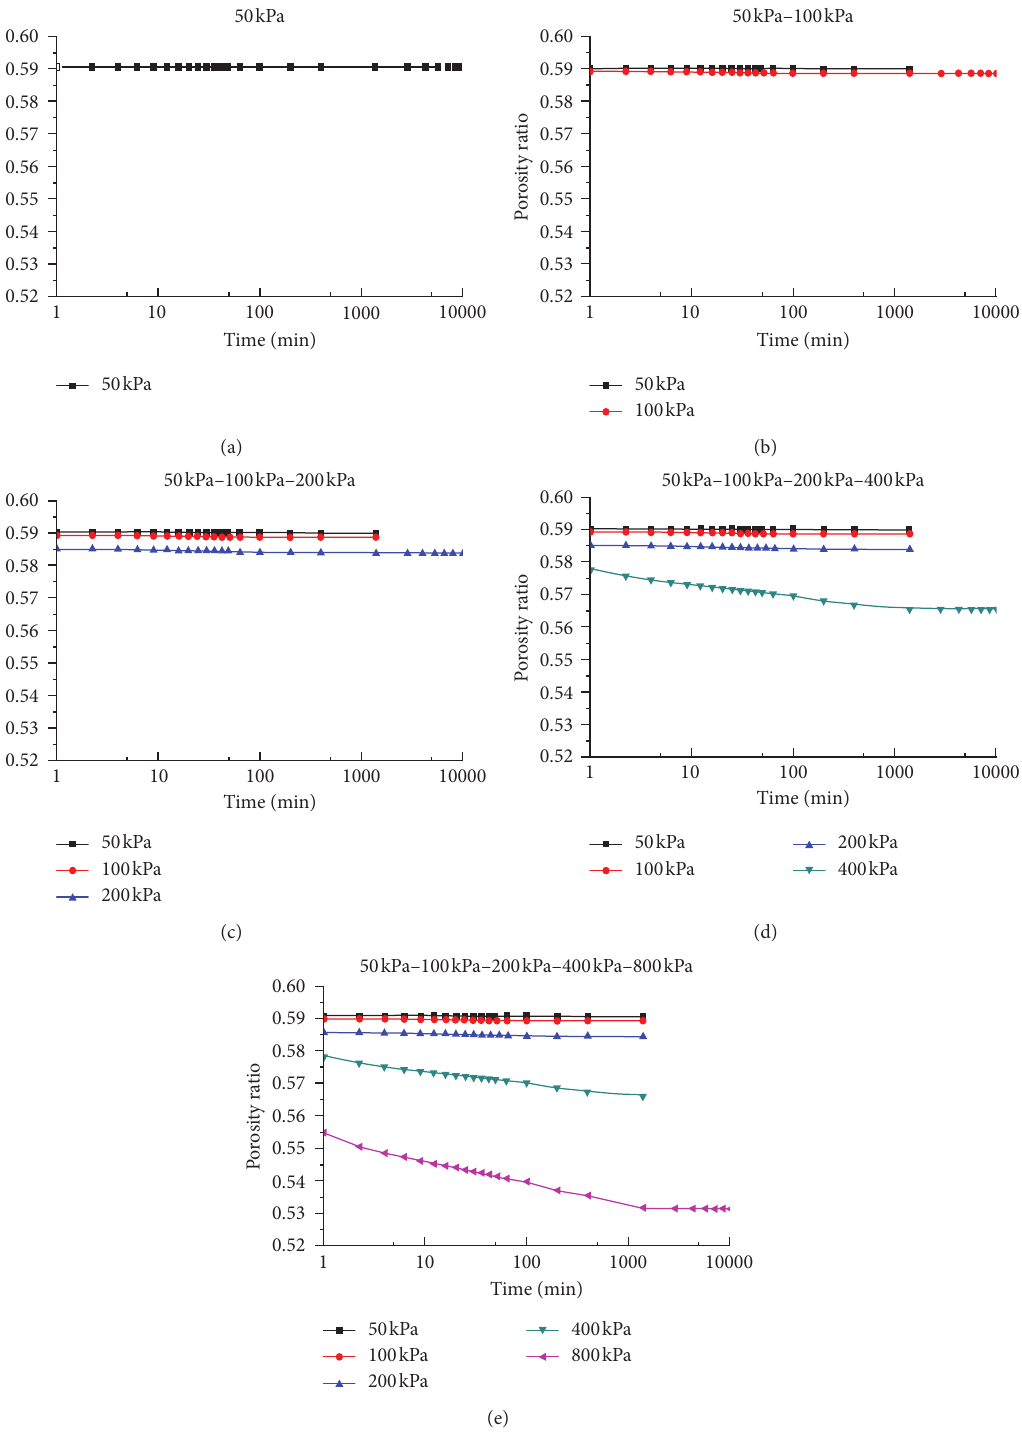
Figure 12: Consolidation test curve of expansive soil under the preload of